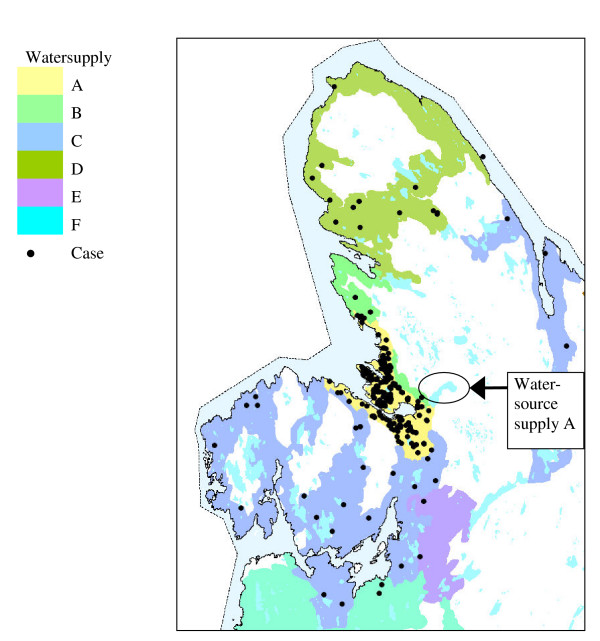
Map of giardiasis cases in Bergen municipality from 1/9 to 1/12 by address of residence and water supply zone (map from water and sewage authority, Bergen municipality).